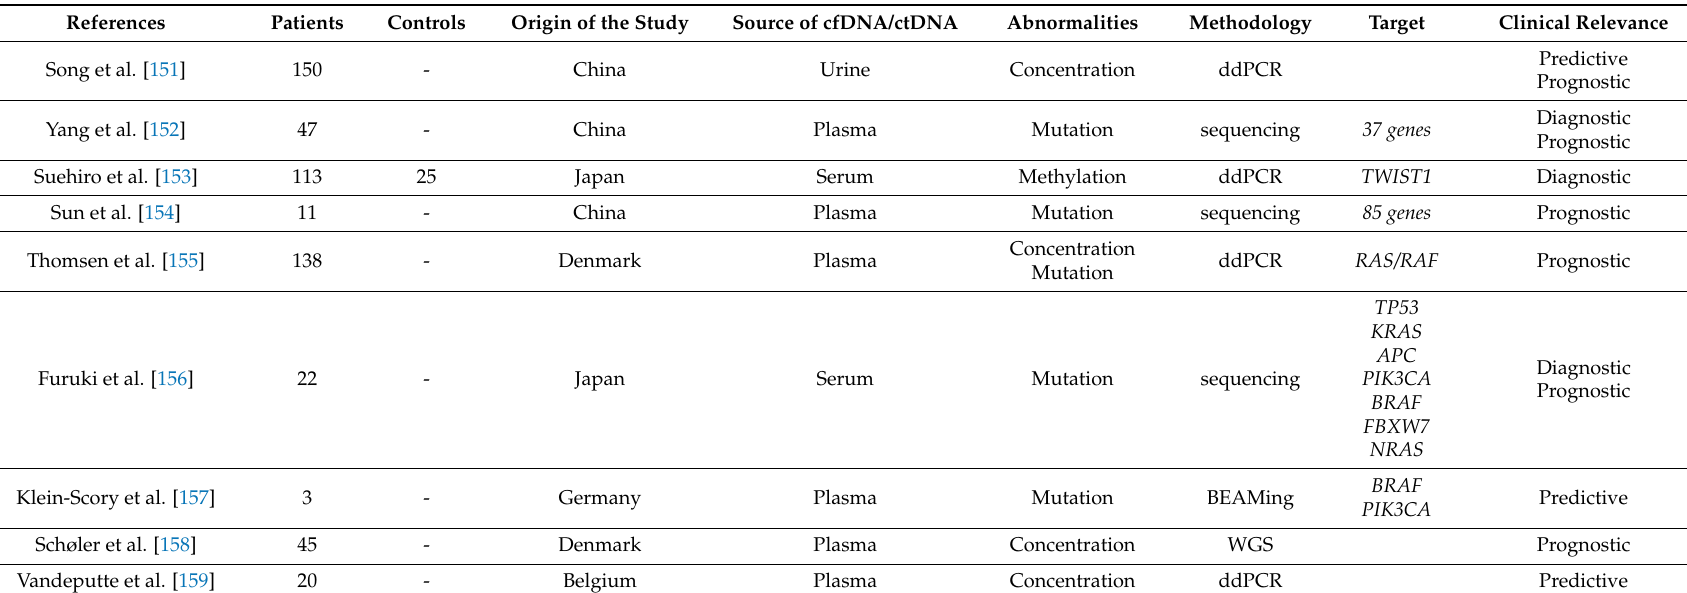
cfDNA: circulating cell-free DNA, ctDNA: circulating tumor DNA, CRC: colorectal cancer, ddPCR: droplet digital PCR; DFA: direct fluorescent assay; dPCR: digital PCR; MS-PCR: methylation specific PCR; qPCR: quantitative PCR; RT-PCR: real-time PCR; SOLID: Sequencing by Oligonucleotide Ligation and Detection; SSCP: single strand conformation PCR: WGS: whole genome